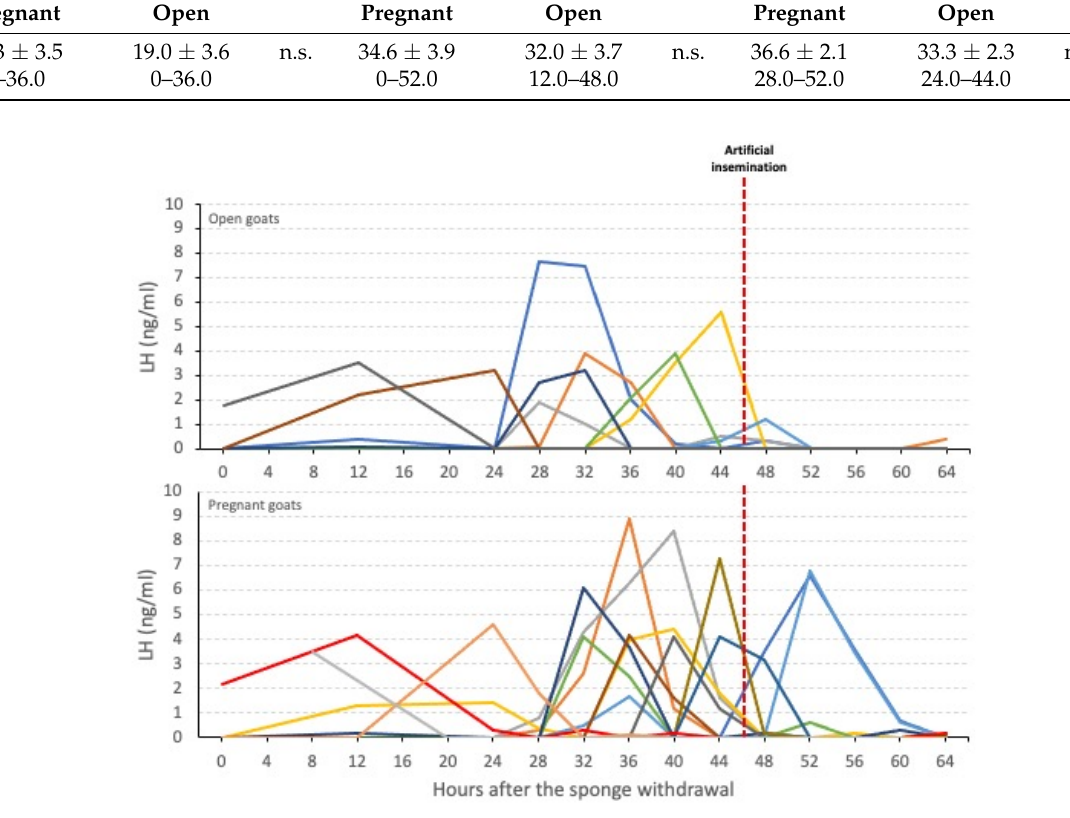
Figure 3. Individual plasma LH profiles in open and pregnant goats after the vaginal sponge withdrawal. Different colorful lines represent individual goats. Red-dashed line indicates the moment of artificial insemination.